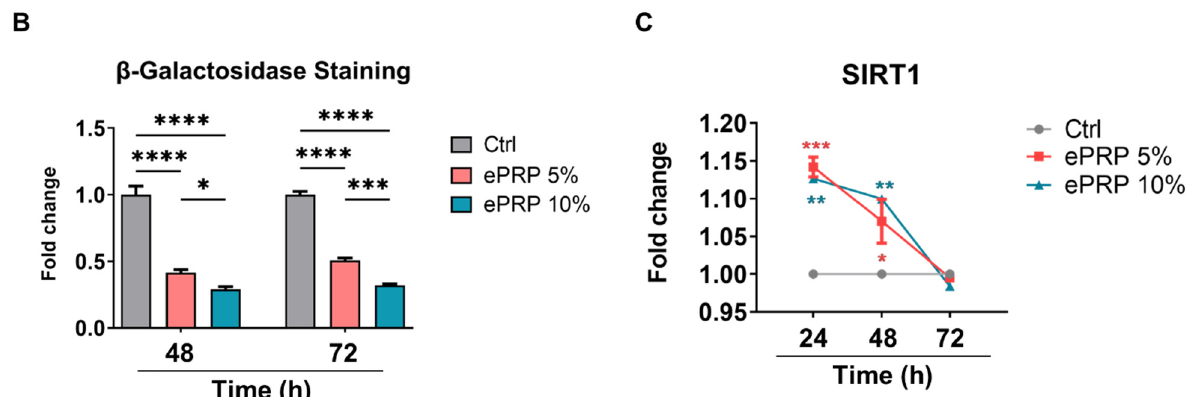
Figure 7. ePRP delays the ageing process in fibroblasts. ( A ) Cells with or without ePRP administration were fixed and stained for senescence β -galactosidase for 48 and 72 h. Microscope images depict senescence β -galactosidase activity intensity in each group. The scale bars indicate a distance of 100 µ m. ( B ) ImageJ software was employed to quantify the fold change of cells positive for senescence β -galactosidase activity. The fold changes are shown as the means ± SEM of three independent experiments (* p < 0.05, *** p < 0.001, **** p < 0.0001). ( C ) The level of SIRT1 mRNA expression was up-regulated in fibroblasts treated with ePRP, as shown by the line chart. Quantitative qPCR was used to determine the gene expression at 24, 48, and 72 h after ePRP treatment. Two-way ANOVA with Tukey’s multiple comparisons test was used to determine statistical significance (* p < 0.05, ** p < 0.01, *** p < 0.001) and means ± SEM were shown (N = 3).